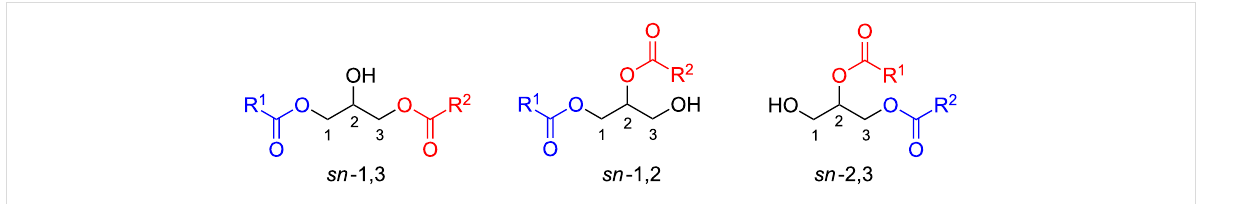
Figure 1: Biologically relevant molecules made, used or derivatized by mechanochemistry.